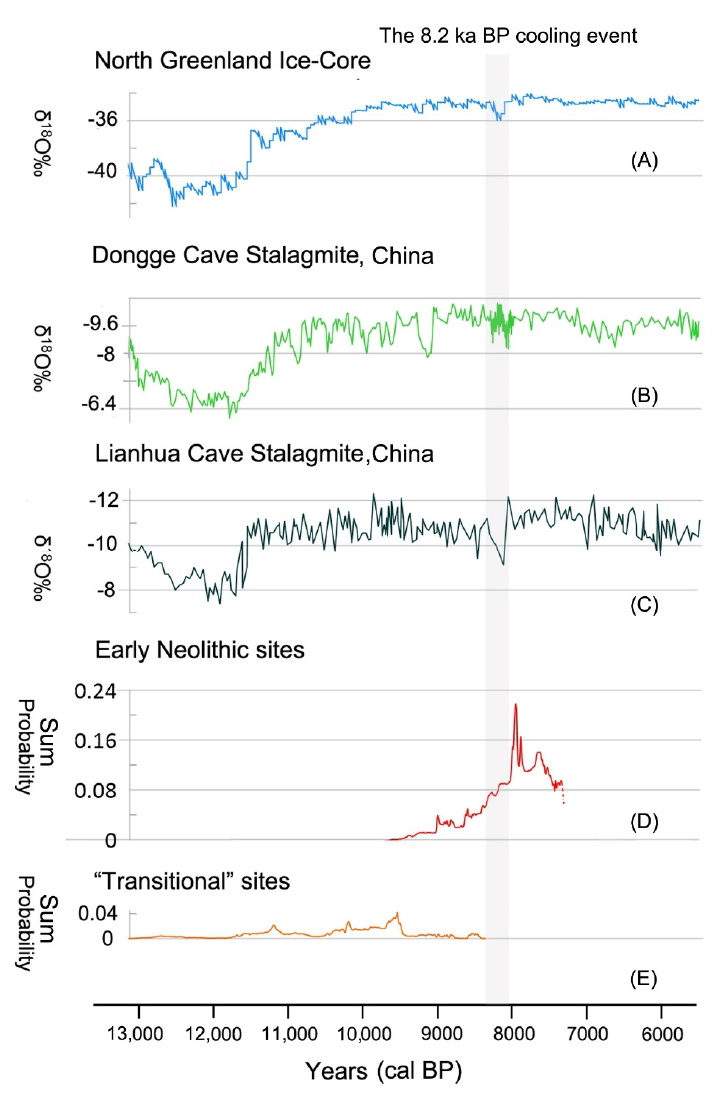
Figure 2. Graphic comparison of human occupation intensity and climate fluctuation. The shaded gray bar shows the time span of the 8.2 ka BP cooling event. The curve ( A ) represents hemispheric changes in precipitation and temperature recorded in the North Greenland ice core [81] . Higher δ 18 O values indicate warmer temperatures and higher humidity. The curve ( B ) represents a proxy for monsoon intensity in South China from the Dongge Cave stalagmite records [31] . Higher δ 18 O values indicate strong winter monsoons (cold/dry) and lower δ 18 O values indicate stronger summer monsoons (warm/wet). The curve ( C ) represents a proxy for monsoon intensity in North China from the Lianhua Cave stalagmite records [33,82] . Higher δ 18 O values indicate strong winter monsoons (cold/dry) and lower δ 18 O values indicate stronger summer monsoons (warm/wet). The curves in ( D ) and ( E ) respectively indicate the relative occupation intensity of the Early Neolithic and the transitional sites across North China based on the sum probability of radiocarbon age estimates. The basic information of the radiocarbon dates (including the dataset of the radiocarbon dating and the explanation of how the sum probability distribution model was built) is presented in the supplementary data.